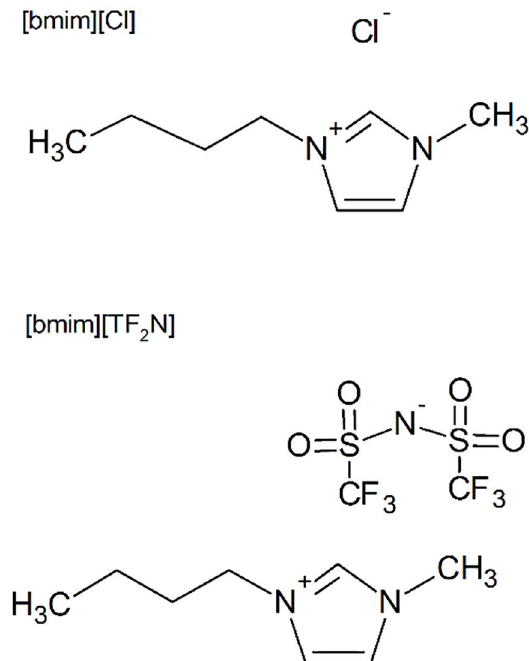
Figure 1. RTILs structures used for silica xerogels